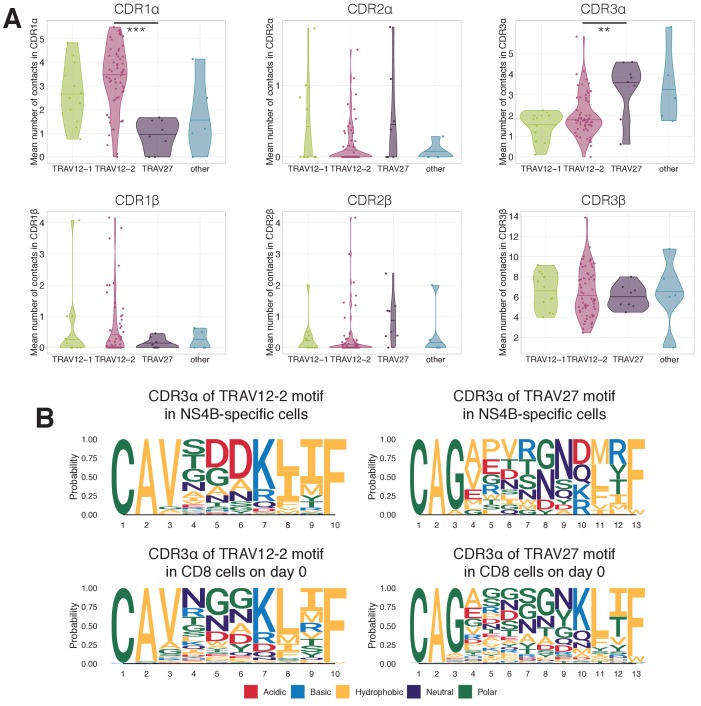
Structural motifs in NS4B-specific TCRs.(A) Average number of contacts to the LLWNGPMAV peptide in complementary determining regions of TCR alpha (top) and TCR beta (bottom) chains. TCRs with TRAV12 segment (green and pink) have significantly more contacts ( Mann Whitney U-test p-value=0.00015) in CDR1α than TCRs with TRAV27 (purple). On the other hand TCRs with TRAV27 have more contacts in CDR3α than TRAV12-2 TCRs ( Mann Whitney U-test p-value=0.009). No significant difference in the number of contacts was observed for these binding modes in CDRs of the TCR beta chain. (B) Frequency of amino acids in CDR3s of clones with TRAV12-2 and TRAV27 V-segments in dextramer-sorted NS4B-specific clonotypes and bulk CD8 clonotypes prior to the vaccination. For TRAV12-2 motif frequency distribution for TRAV12-2 is close to observed in bulk, suggesting absence of strong selection for certain amino acids in certain positions. .